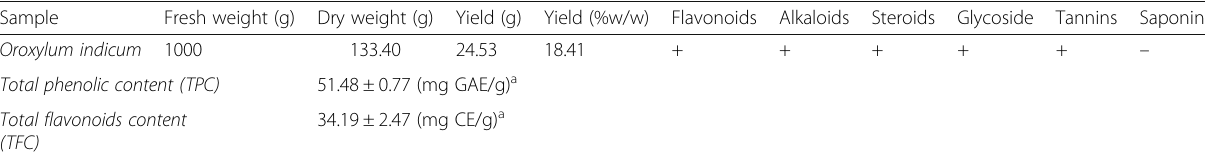
Table 1 Extraction yield and phytochemical composition of Oroxylum indicum fruit extract. Extraction yield, total phenolic content, total flavonoid content and phytochemical composition of Oroxylum indicum fruit extract